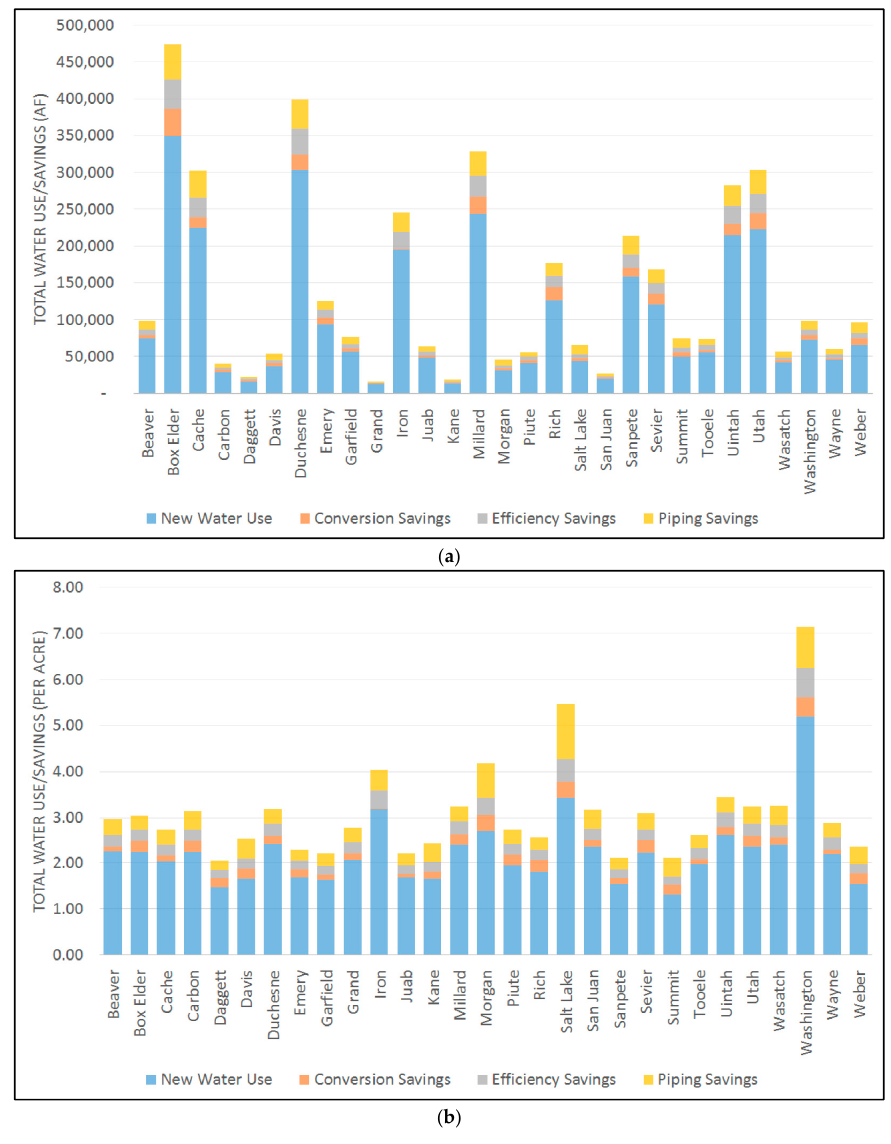
Figure 2. Agricultural water savings in Utah counties: ( a ) total water savings; ( b ) per-acre water savings.